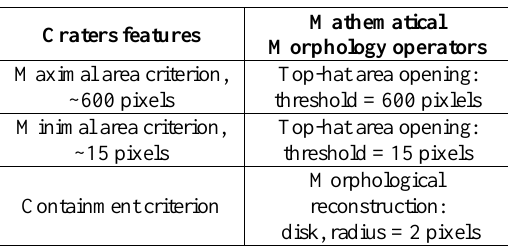
Table 2. Craters characteristics and the corresponding Mathematical Morphology operators